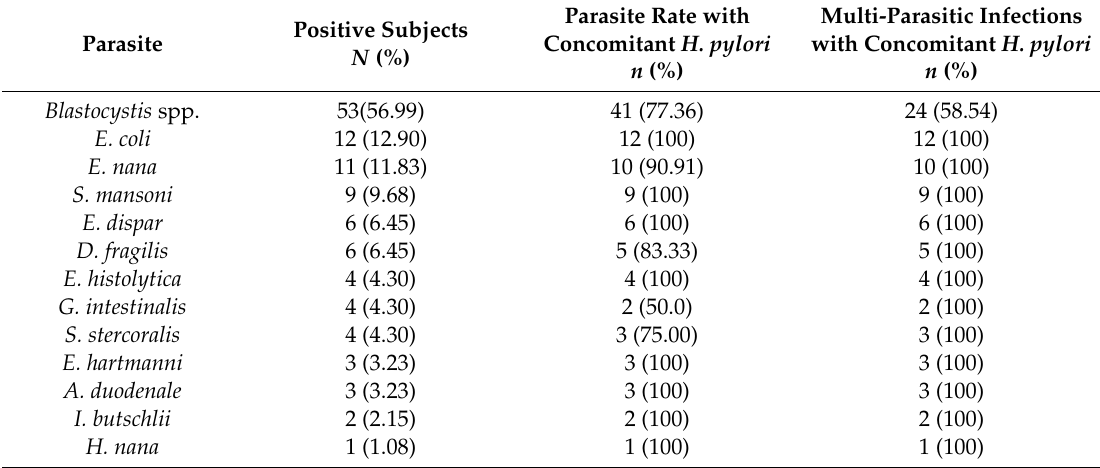
Table 3. Rate of intestinal parasitic infections and mixed infections found in the cohort.